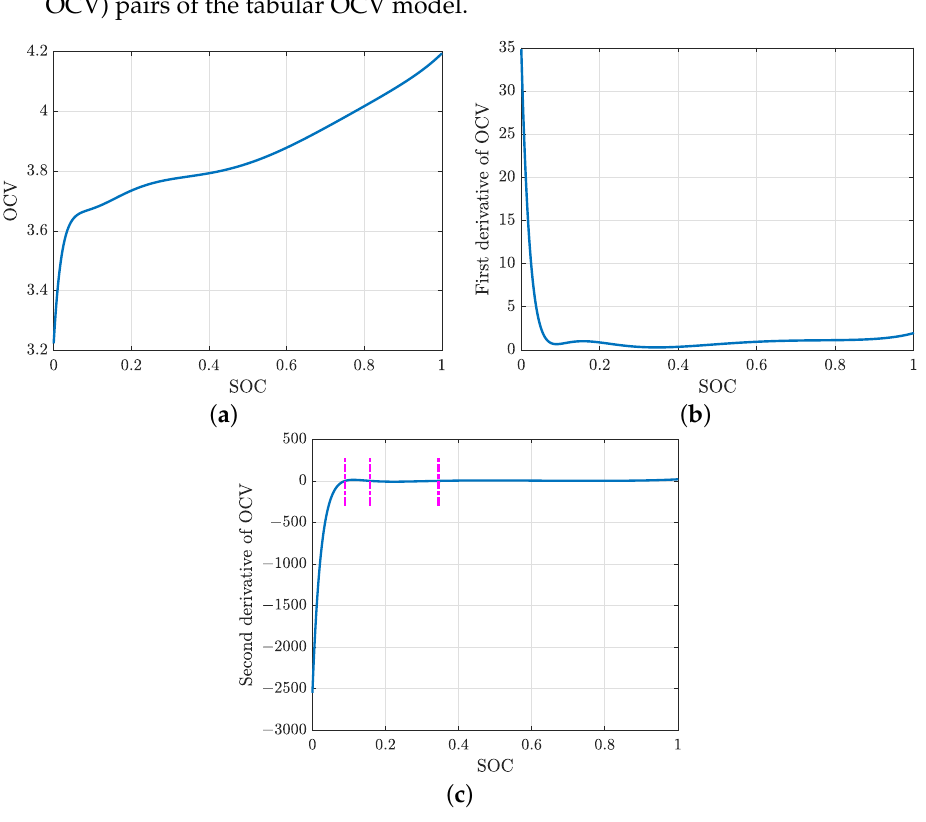
Figure 9. OCV model and its first two derivatives—( a ) OCV model- V ◦ ( s ) , ( b ) first derivative- V (cid:48) ◦ ( s ) , and ( c ) second derivative- V (cid:48)(cid:48) ◦ ( s )